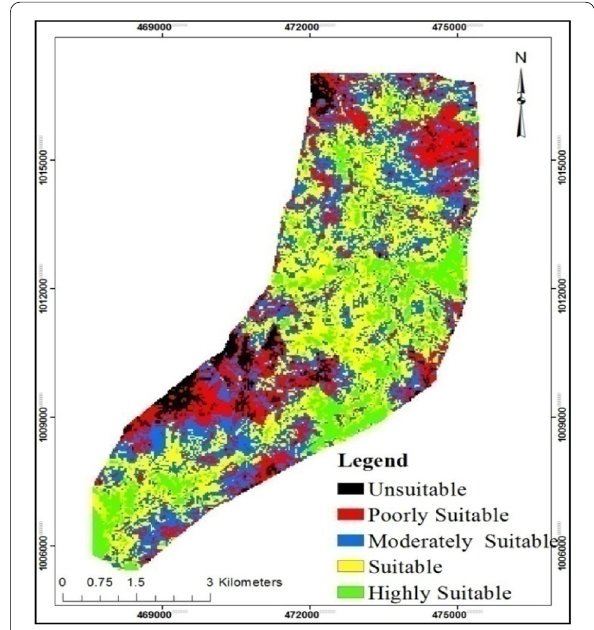
Fig. 3 Final suitability map for urban green spaces